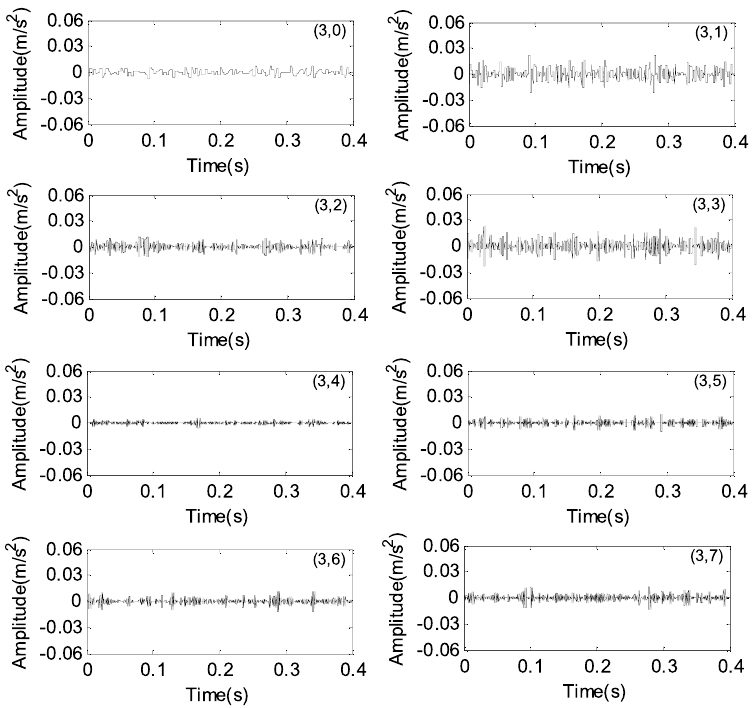
Fig. 8. Three-level decomposition of the experimental vibration signal under F 2 fault condition.